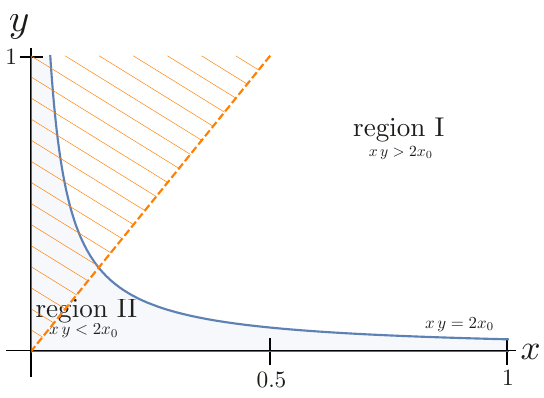
Figure 15 . The two regions defined in the two-dimensional profile function given in eq. (3.30). All θ g and ∆ E -dependent scales take on their canonical values in region I and begin to freeze once they enter region II. The involved scales are properly defined only within the factorization of regime B, satisfying the condition ∆ E < z cut θ β . This condition is indicated by the orange hatched region for g z cut = 0 . 5 and β = 1 , identifying x and y with ∆ E and θ g ,